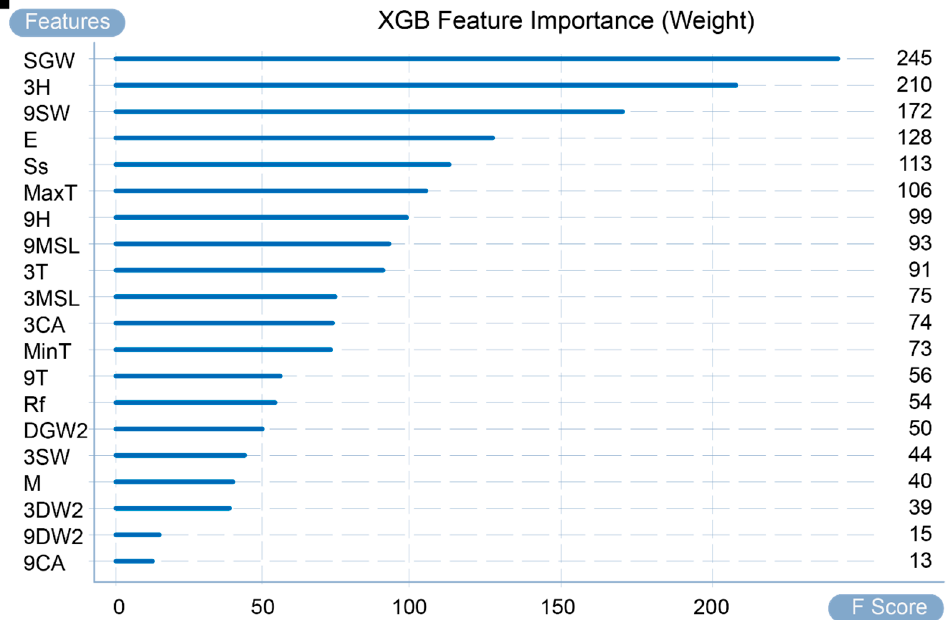
Figure 5. Feature importance by weight.